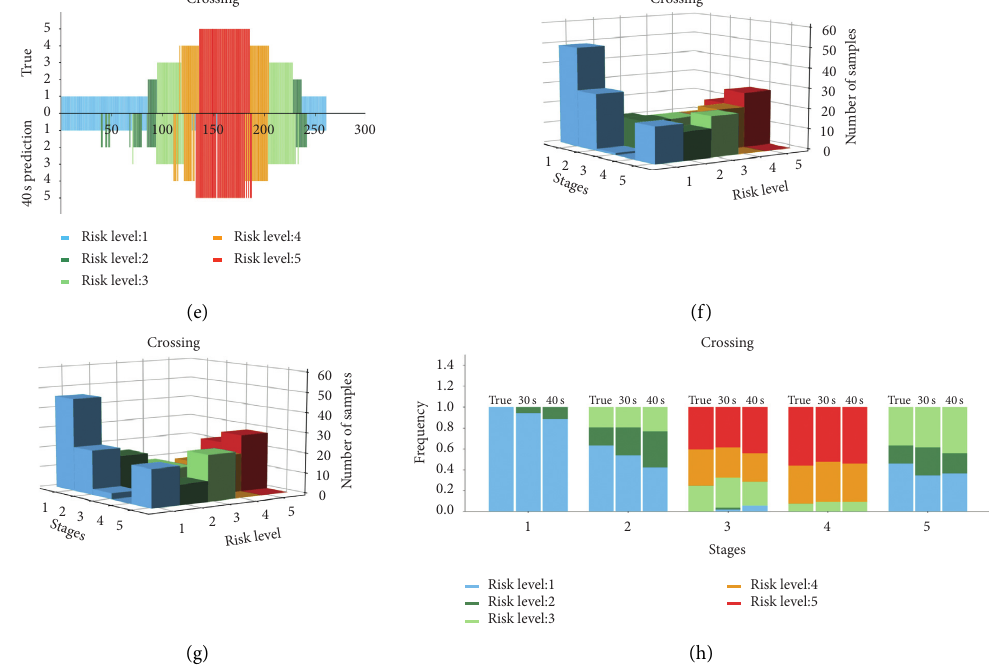
Figure 9: Crossing situation: (a) and (b) are the spatial distributions of risk level under various prediction horizons; (c) is the corresponding spatial distribution of realistic risk level. (d) and (e) show the risk level statistics of each window under two prediction horizons. (f) and (g) are the number of samples of each risk level in the five stages. (h) is the frequency of each risk level at various stages.